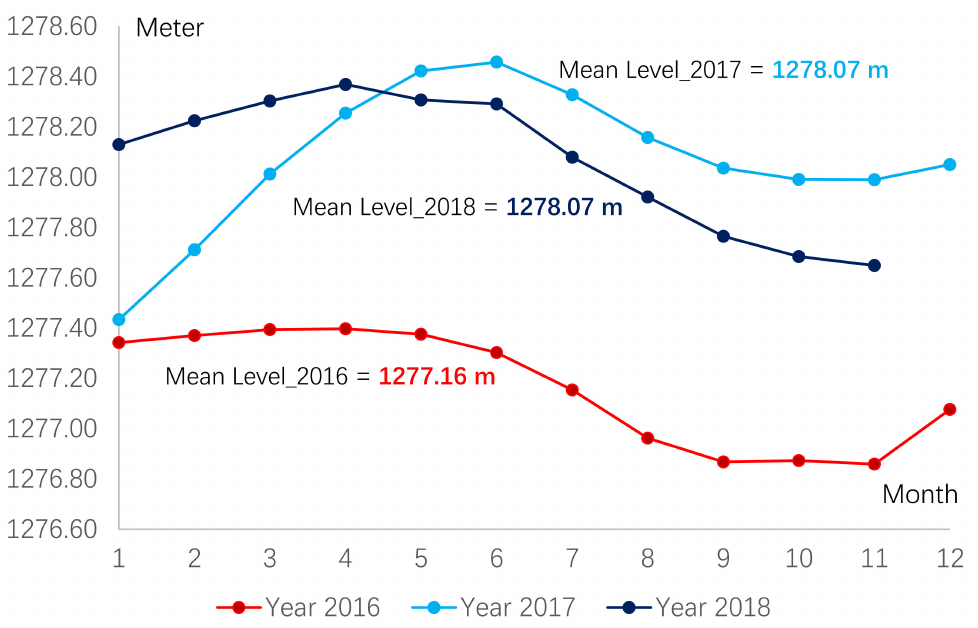
Figure 5. GSL monthly water levels in 2016 and the big increases in 2017 and 2018. This figure is plotted on a monthly scale from January 1, 2016 to November 30, 2018, which is calculated and processed using the GSL daily water level records that are available online at http://greatsalt.uslakes.info/Level.asp provided by